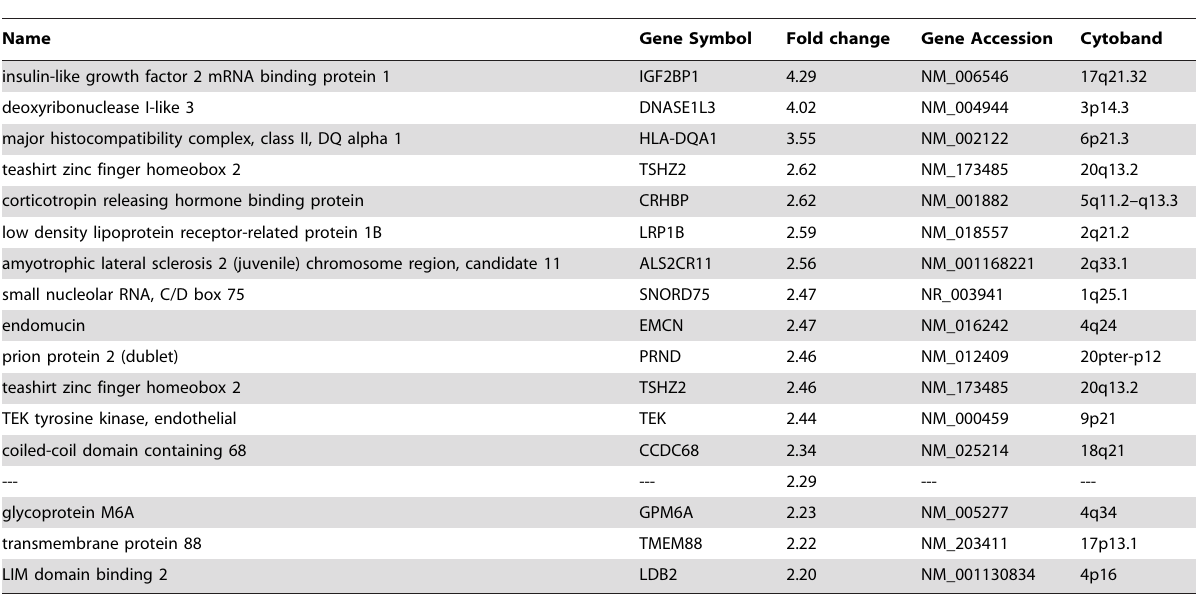
Table 1. Most up-regulated genes in the pulp tissue of deciduous teeth as compared to permanent teeth.